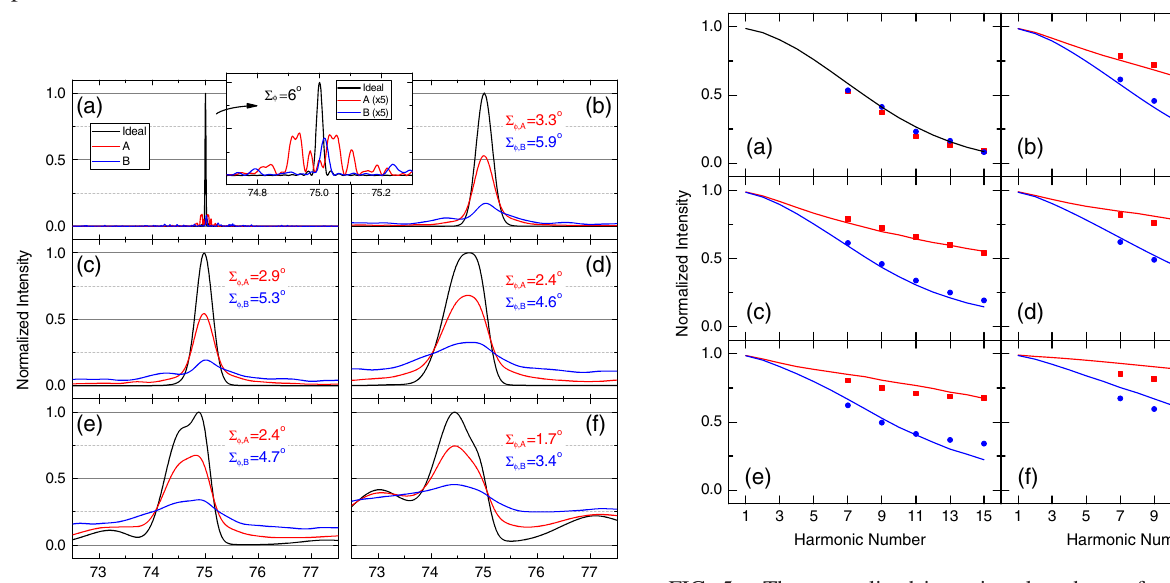
FIG. 5. The normalized intensity plotted as a function of the harmonic number for the six conditions (a) – (f), which are numerically ( I r =I 0 , symbols) and analytically ( ρ , solid lines) evaluated. Red and blue colors indicate the results for the undulator models A and B,